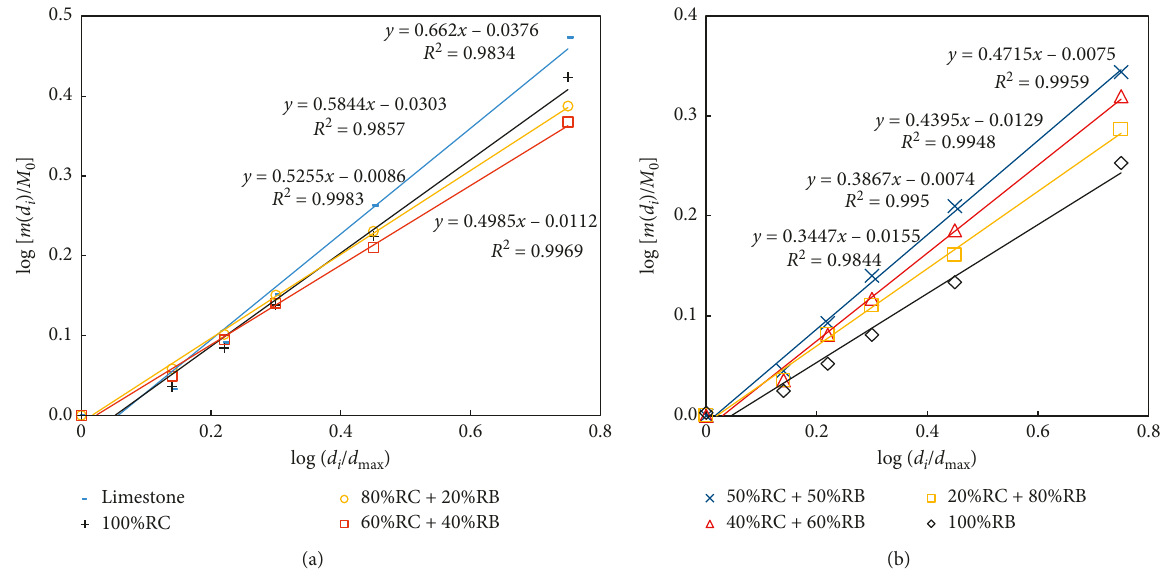
Figure 3: Relationship between lg ( d 26.5mm with various mixing ratios (the values are expressed as absolute values).